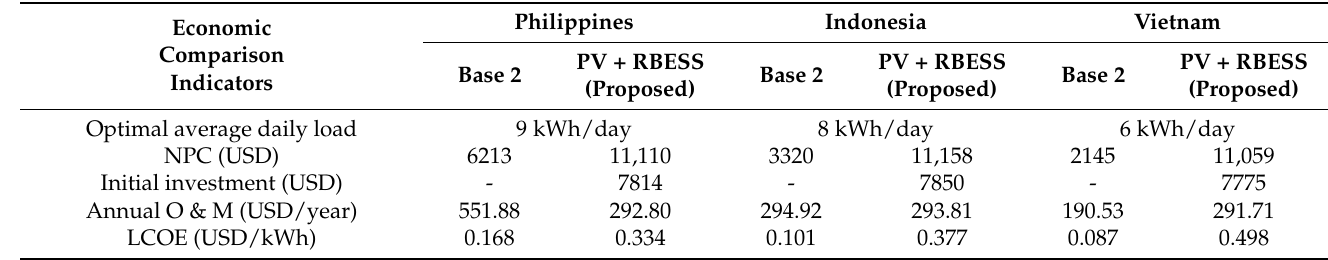
Table 15. LCOE comparison with Base 2 system at optimal daily average